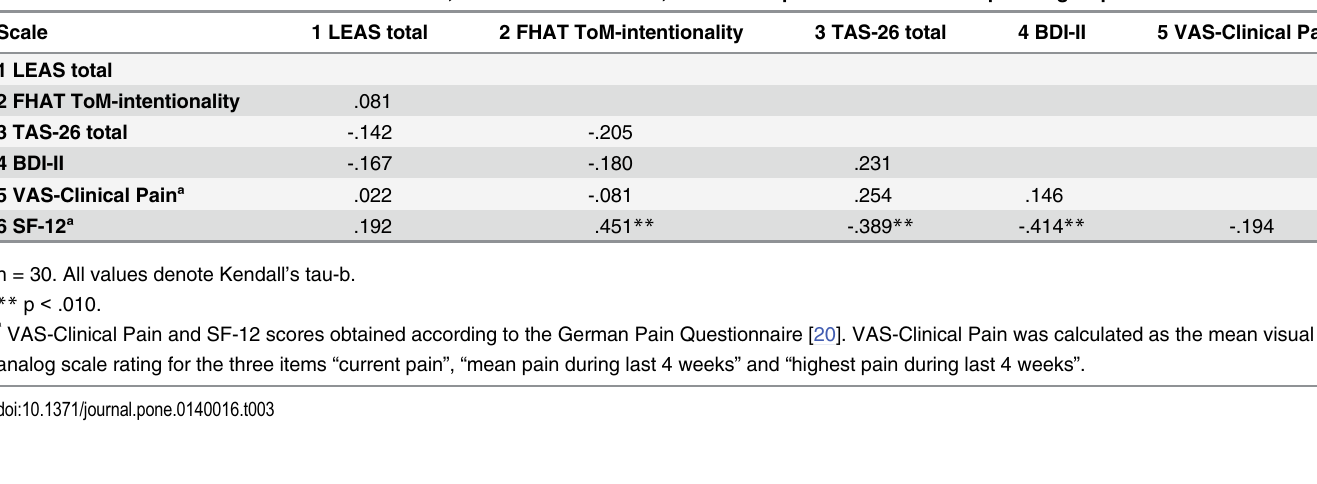
Means ± 95% Con fi dence Interval.